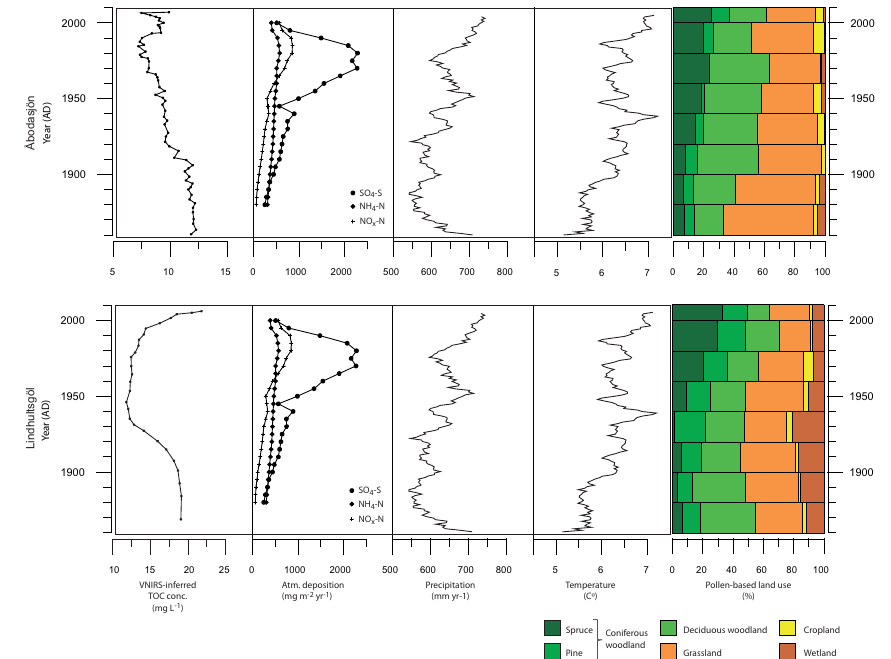
Figure 3. Records of VNIRS-inferred lake-water total organic carbon (TOC) concentration and pollen-based land use since AD1900 from Åbodasjön and Lindhultsgöl plotted together with atmospheric sulfur (sulfate SO 4 ) and nitrogen (ammonium (NH 4 ) and nitrogen oxides (NOx)) deposition (from the Swedish Environmental Research Institute MAGIC model) and climate data from Växjö (annual precipitation and temperature expressed as 10-year running